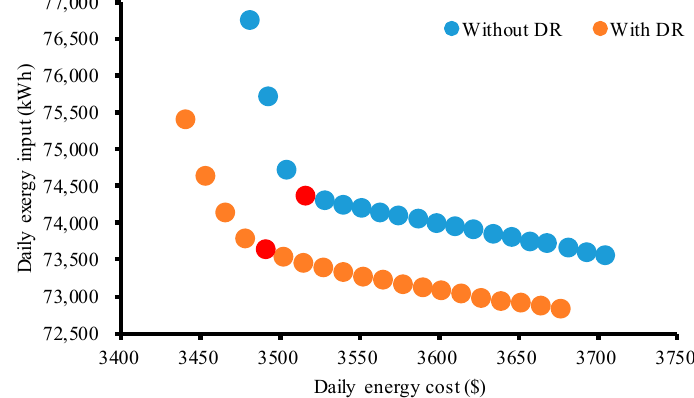
Figure 6. Pareto front with and without demand response (DR). Table 3. Pareto optimal solutions by the ε -constraint method.